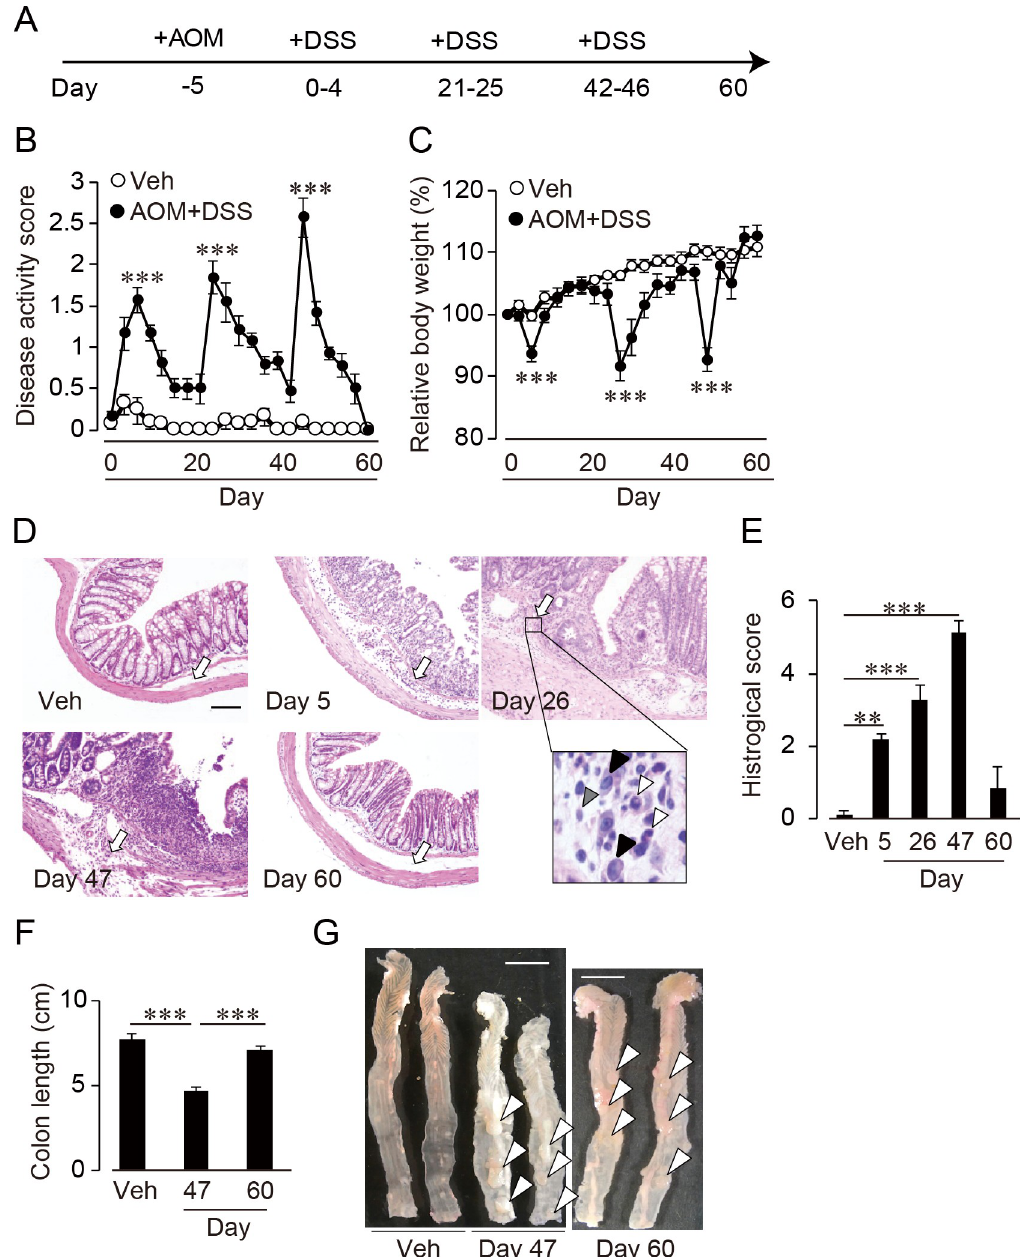
Fig 1. AOM/DSS-induced colitis and CAC in mice. (A) Schematic figure of AOM/DSS administration. (B) DAI and (C) body weight (n = 8–26). Body weight is showed as a value relative to the ratio of the body weight at day 0. (D) Representative histological images (hematoxylin & eosin staining) of colon on day 5, 26, 47 and 60 compared with vehicle treatment group. Black arrow, normal or damaged mucosa; white arrow, infiltrating cell; black arrowhead, macrophage; white arrowhead, neutrophil; grey arrowhead, lymphocyte. Scale bar, 100 ε m. (E) Histological scoring of colon inflammation (n = 6–10). �� , p < 0.01; ��� , p < 0.001. (F) Colon length on day 47 and 60 compared with vehicle treatment group (n = 8–13) and (G) macroscopic images of a whole colon. White arrowhead, tumor. Scale bar, 1 cm. ��� , p < 0.001. https://doi.org/10.1371/journal.pone.0245292.g001 cycle was performed three times. Colon tissue was sampled at day 5, day 26, day 47 and day 60. No randomization was used to allocate mice to any groups and confounders were not con- trolled. The number of mice were 13 in vehicle group and 8–26 in AOM/DSS administration